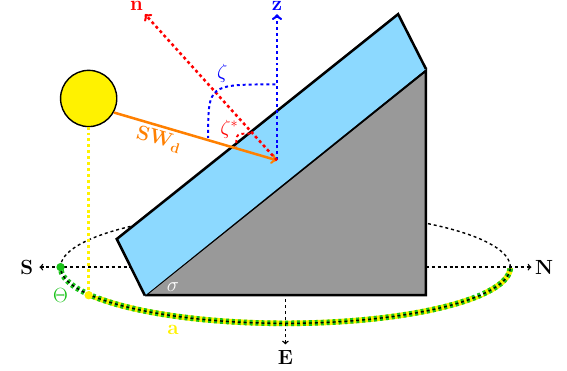
Figure 8. Scheme of a tilted plane as described in the GIMP DEM at 1km. SW d is the downward shortwave radiation, ζ ∗ is the solar angle of incidence for a tilted plane, ζ is the solar zenith angle, a is the azimuth of the tilted plane, σ is the local surface slope and (cid:50) is the orientation. n and z are respectively the vector normal to the tilted plane and the local vertical